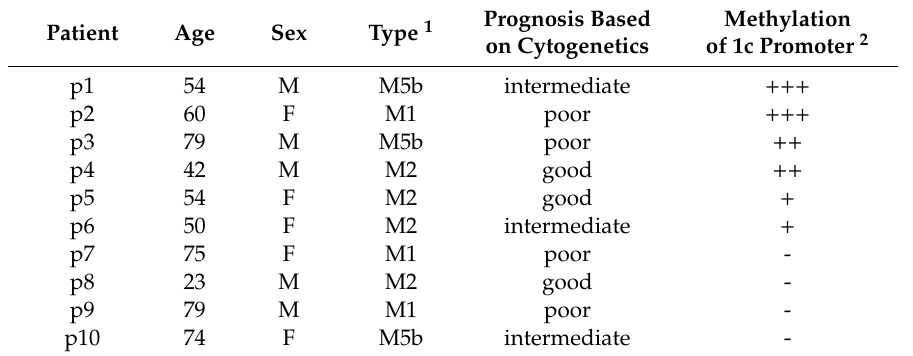
Figure 3. Methylation of CpG islands in the promoter regions of human VDR . ( a ) CpG islands were identified in the promoter regions of human VDR gene using MethPrimer software. The localization of the CpG islands relative to VDR exons is presented. Methylation patterns of CpG islands were examined in ( b ) normal human blood cells, ( c ) human leukemic cell lines, and ( d ) human AML blasts. The mean ( ± SEM) proportion of methylated cytosines in the respective CpG islands are presented on the graphs. Table 1. Characteristics of the patients whose acute myeloid leukemia (AML) blasts were studied.